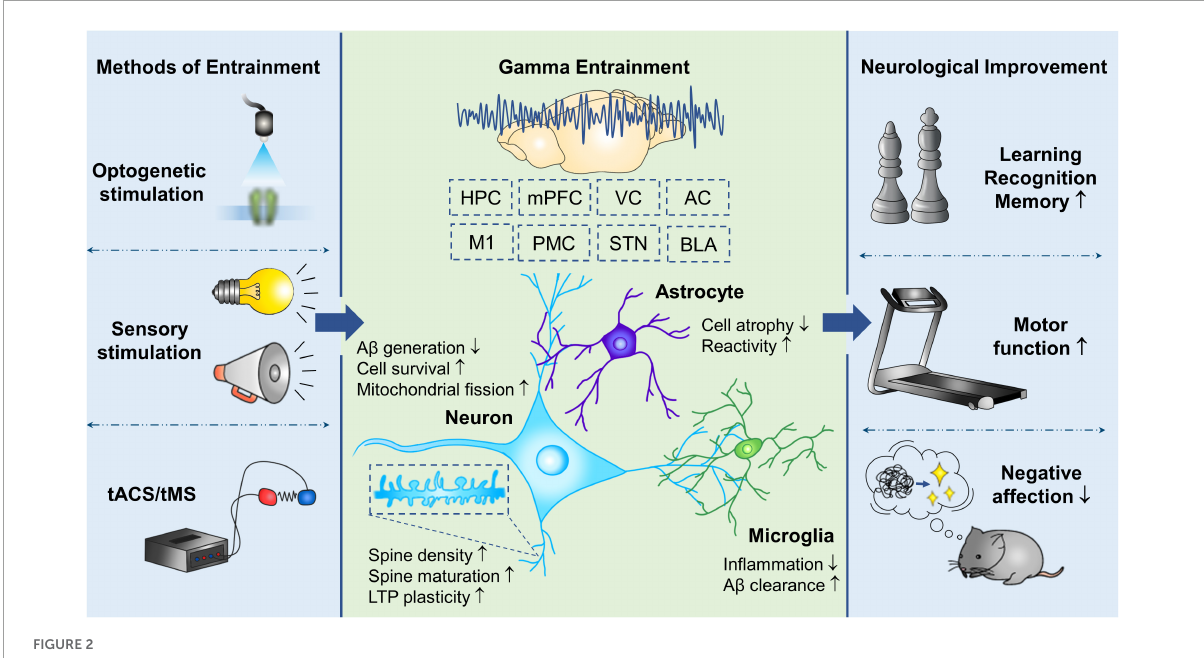
FIGURE2 Therapeutic effects of gamma entrainment in CNS diseases. Invasive and non-invasive methods are utilized to evoke gamma entrainment in different brain regions, which provides neuroprotection directly on neurons, as well as modulation of glial reactive states, and consequently improves various neurological functions. tACS, transcranial alternating current stimulation; tMS, transcranial magnetic stimulation; HPC, hippocampus; mPFC, medial prefrontal cortex; VC, visual cortex; AC, auditory cortex; M1, primary motor cortex; PMC, premotor cortex; STN, subthalamic nucleus; BLA, basolateral amygdala; LTP, long-term